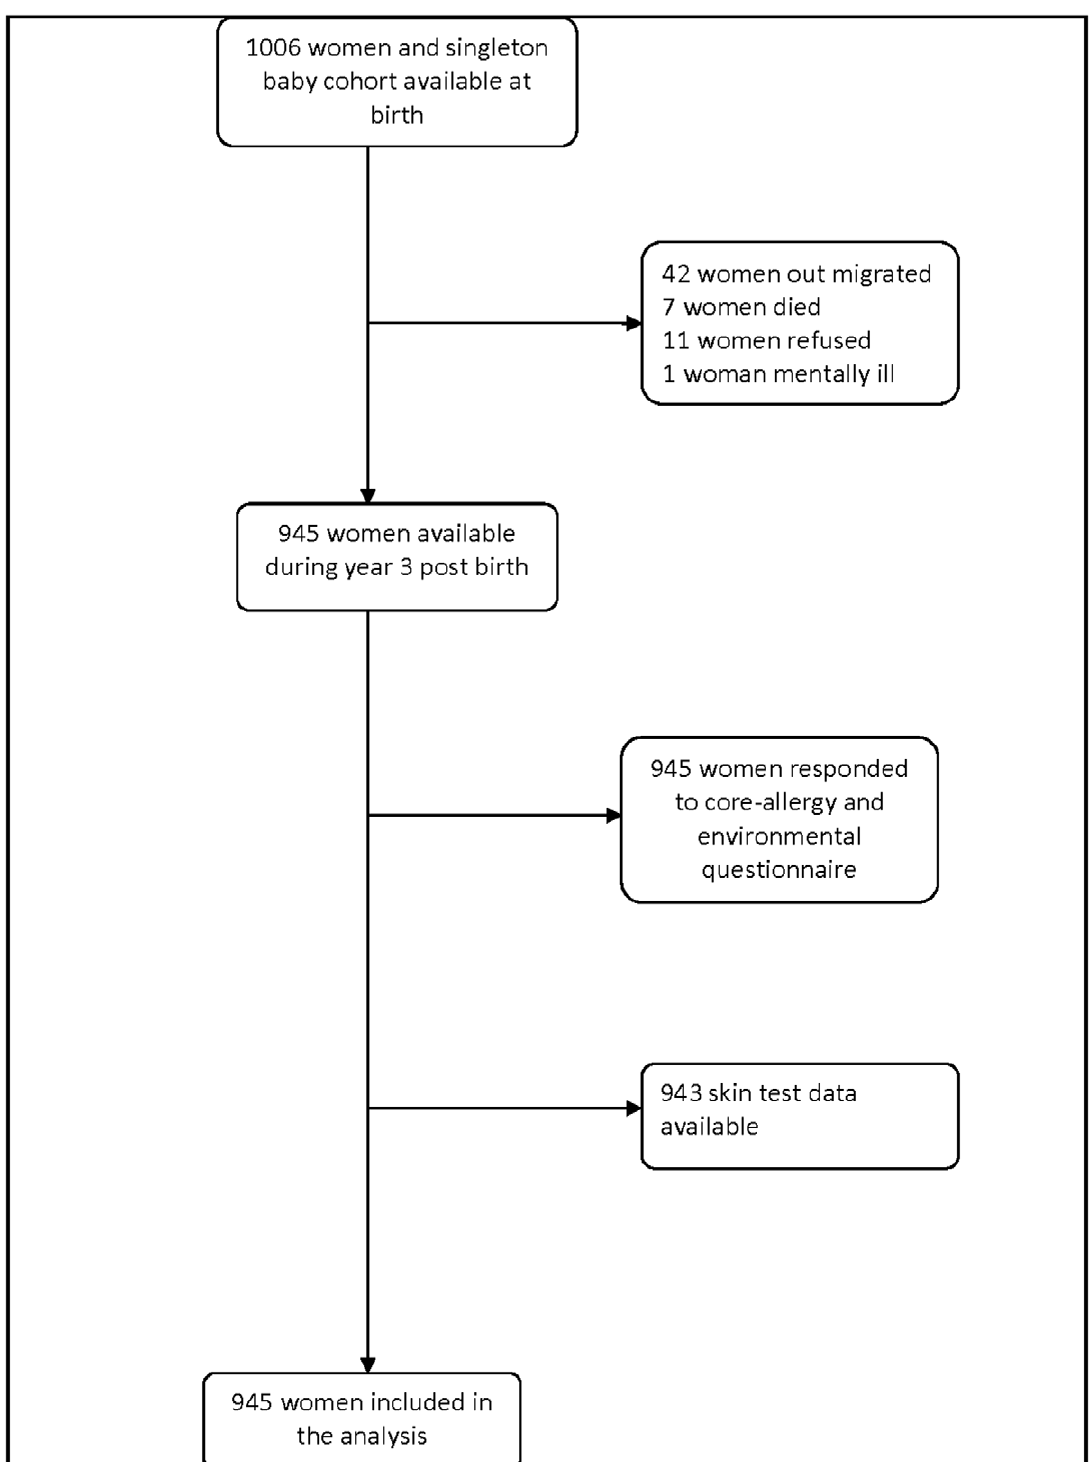
Figure 1. The birth cohort of women. doi:10.1371/journal.pone.0022551.g001 Asthma was reported in 1.7% (16/945) of women, hay fever in 3.8% (36/945), and eczema in 0.9% (8/945), with a combined